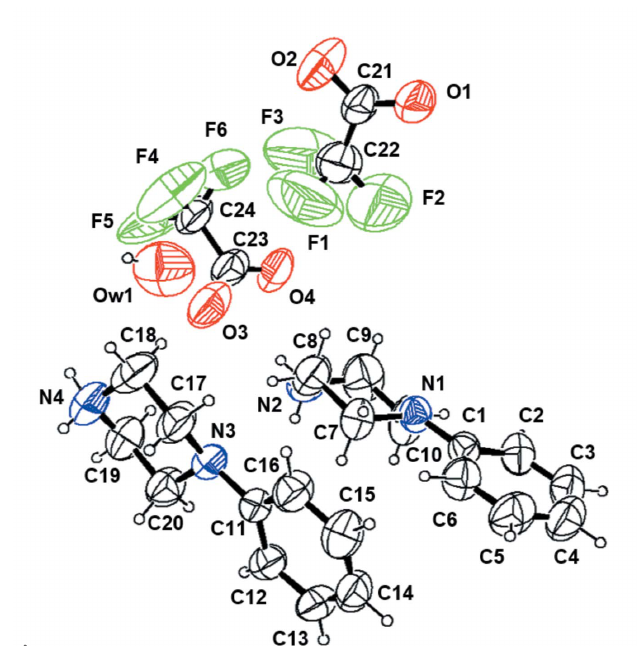
Figure 4 The independent components of compound ( IV ) showing the atom- labelling scheme. Displacement ellipsoids are drawn at the 30% probability level. (Atom splitting is omitted for clarity.) chair conformation for the cation A 2, with puckering para-